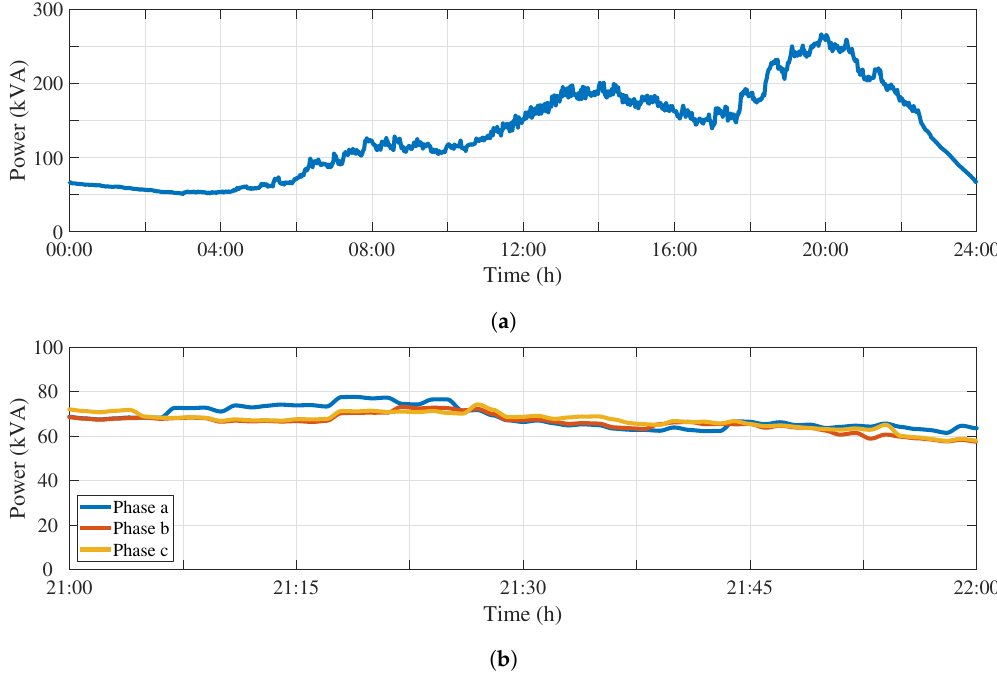
Figure 2. ( a ) Daily consumption profile at the transformer level for the residential subnetwork. ( b ) The residential subnetwork consumption per phase at the transformer level for the selected time period.